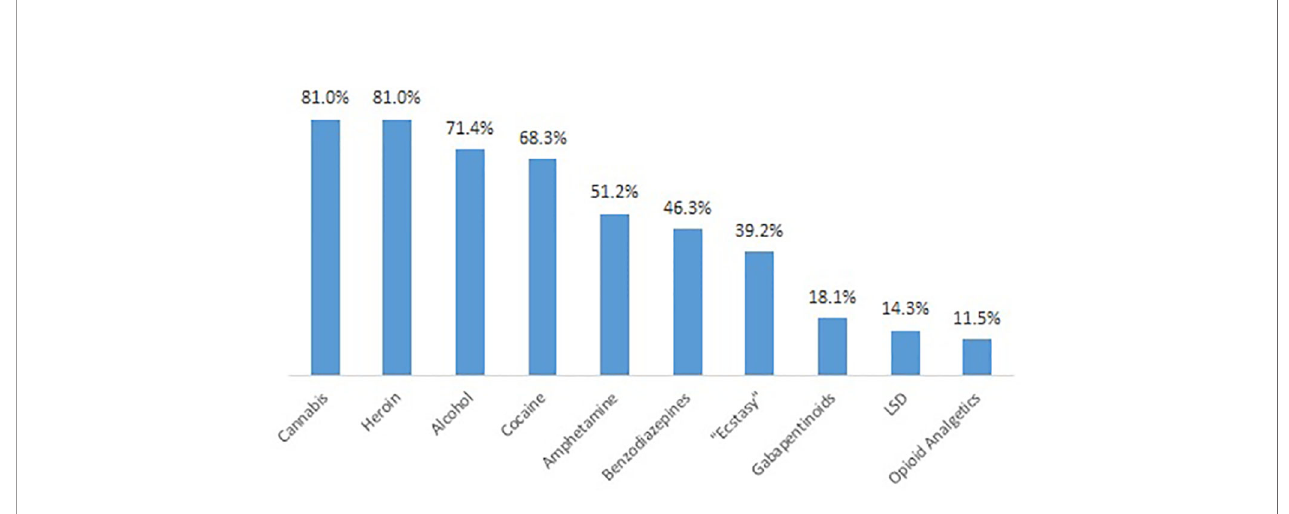
FIGURE 3 | Top 10 of substances used regularly during